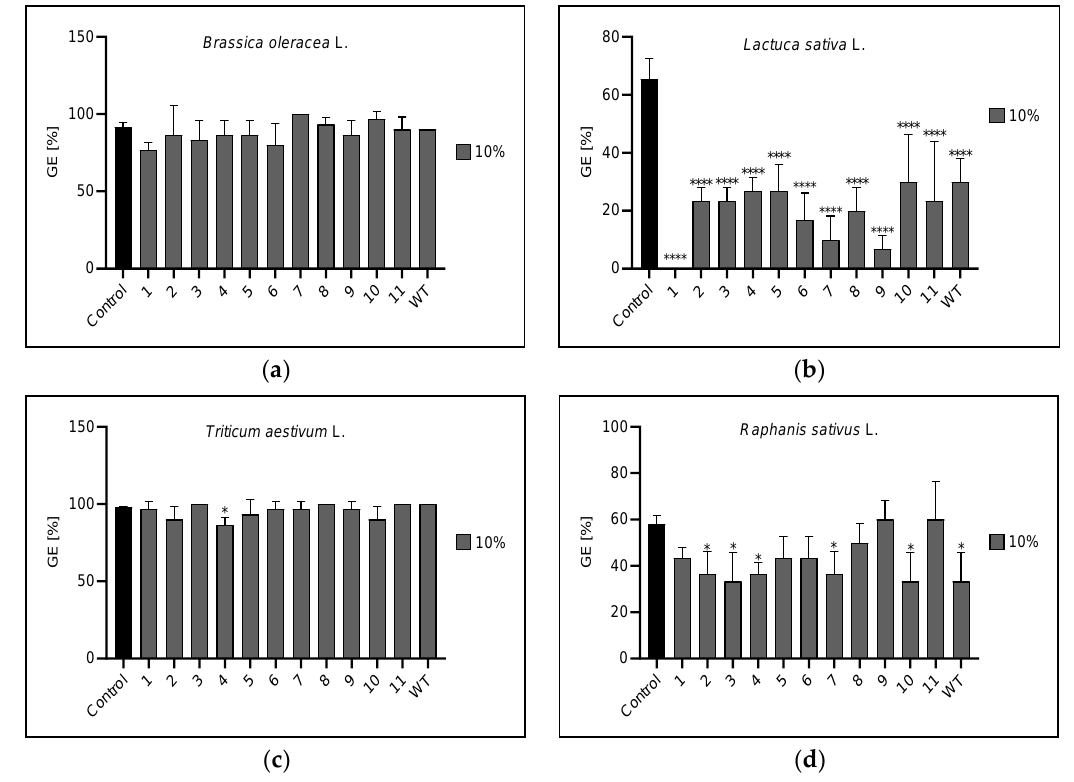
Figure 4. Percentage of germination of broccoli ( a ), lettuce ( b ), wheat ( c ), and radish ( d ) seeds treated with 10% concentration for all algae clones tested (1-11, WT) and control (Control). Values represent mean ± SD, n = 10 plants, * p < 0.1, **** p < 0.0001 compared to control (ANOVA and Dunnett’s a posteriori test).